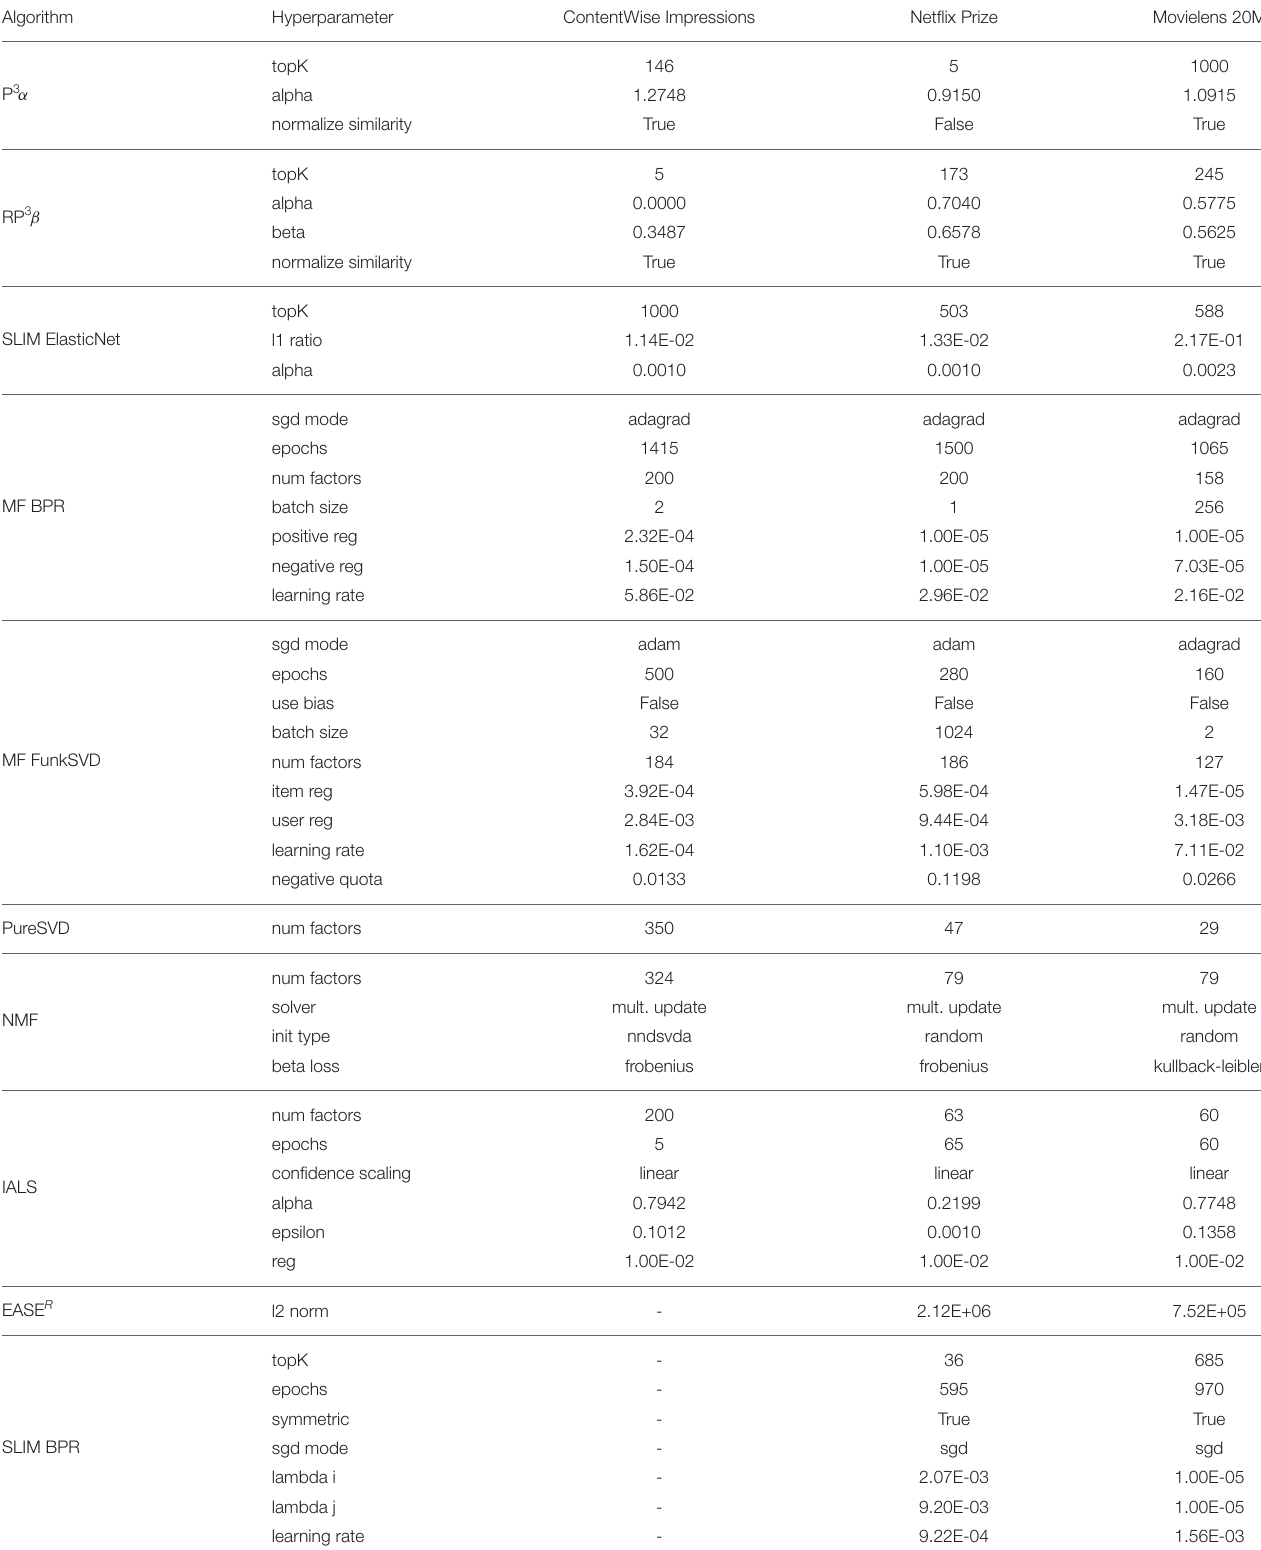
TABLE A3 | Hyperparameter values for machine learning and graph based recommender algorithms on all datasets.